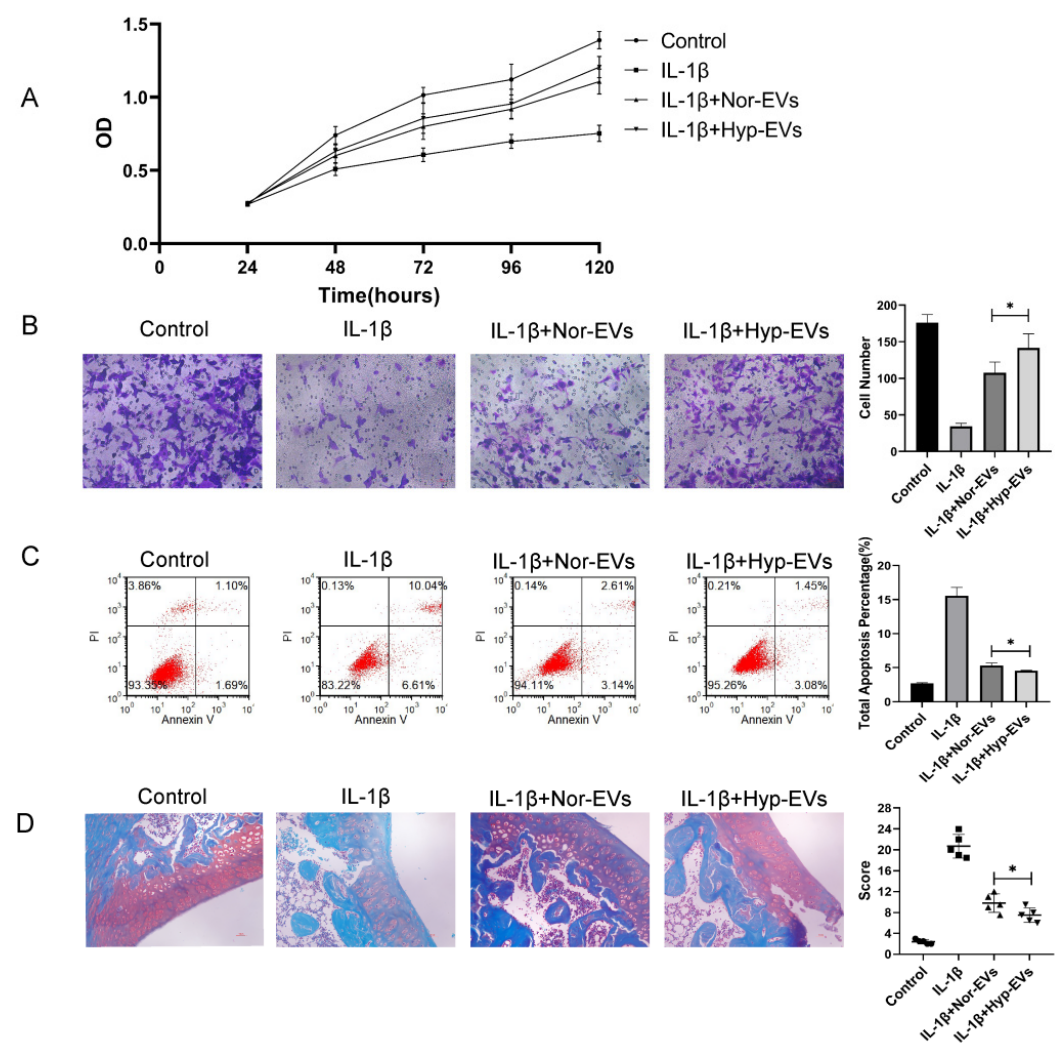
Figure 3. Hypoxia preconditioning improved the therapeutic effects of BMSC-EVs in vitro and in vivo. ( A ) The proliferation of chondrocytes was evaluated by CCK-8 assay. ( B ) Chondrocyte migration was determined by the Transwell migration assay (Scale bar = 50 µ m). ( C ) Flow cytometry was used to analyze apoptosis in inflammatory chondrocytes. ( D ) Safranin O and fast green staining of knee joint specimens of rats that were treated with normoxia-EVs or hypoxia-EVs. Statistical analysis of the OARSI score in rats treated with normoxia-EVs or hypoxia-EVs. * p < 0.05. Based on the criteria of p < 0.05 and FC > 2 or <0.5, a total of 12 significant differentially expressed miRNAs were identified by miRNA sequencing and selected for validation by the GSE156919 dataset in the GEO database (Figure 4C). Consistent with the miRNA sequencing results and the GSE156919 dataset, the validation data showed that hsa-miR- 181c-5p (FC = 0.26, p < 0.001), hsa-miR-18a-3p (FC = 0.11, p < 0.05), hsa-miR-376a-5p (FC = 0.16, p < 0.05), and hsa-miR-337-5p (FC = 0.46, p < 0.05) were downregulated in hypoxia-EVs; a total of 913 possible target genes of these 4 miRNAs (931 possible target genes, including 18 duplicates) were predicted by using mirdb and TargetScan (Figure